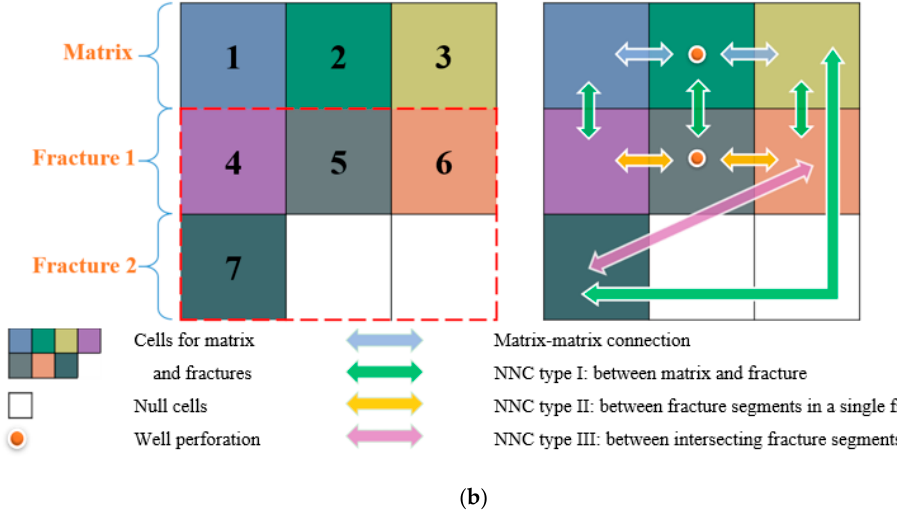
Figure 1. Illustration of the non-intrusive embedded discrete fracture model (EDFM) method for modeling 3D complex fractures (NNC represents non-neighboring connection) [25]: ( a ) the complex fractures in the physical domain; and ( b ) the matrix and fracture cells in the computational domain.